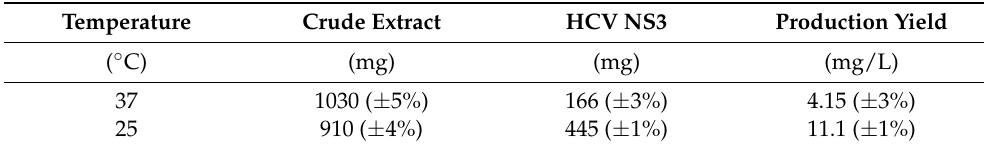
Figure 2. Purity and specificity of purified HCV NS3 antigens on SDS-PAGE ( a ) and western blotting ( b ). Lane 1 and lane 2 are long-term-stored and fresh NS3 antigens produced at 37 °C, respectively. Lane 3 and lane 4 are long-term stored and fresh NS3 antigens produced at 25 °C, respectively. Table 1. Production yield of HCV NS3 in a 40 L reaction, with incubation temperatures of 37 °C and 25 °C.